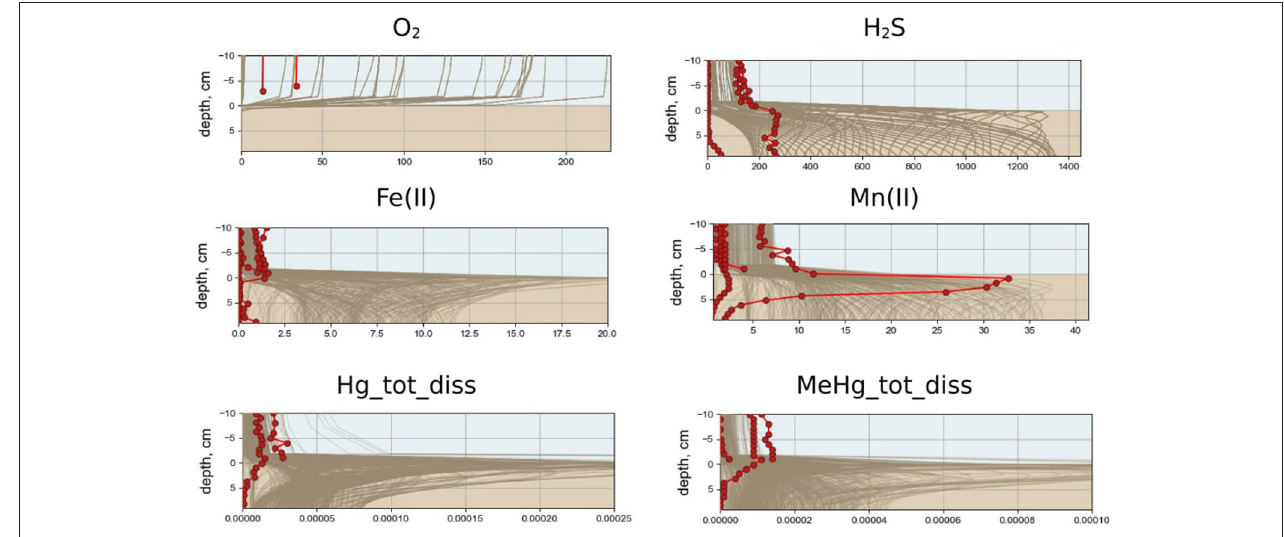
FIGURE 4 | Annual variability of simulated vertical distribution of dissolved oxygen, hydrogen sulfide, Fe(II), Mn(II), total dissolved Hg, and MeHg ( µ M) for scenario S1 (lines) and measured in summer 2009 and summer 2010 (dots) in the bottom water and at upper sediment layer in the Berre